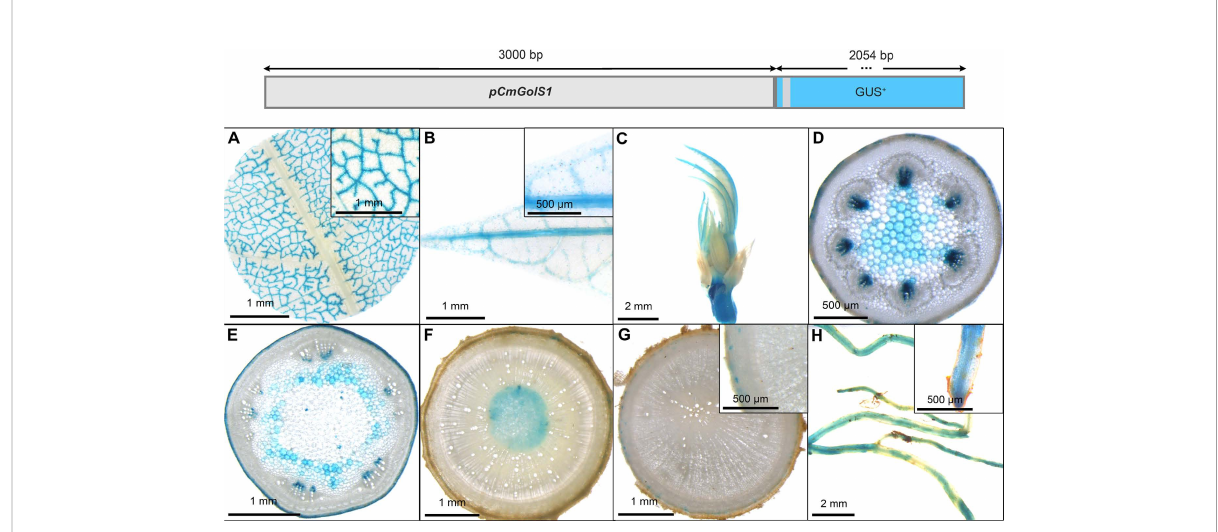
FIGURE 5 Representative GUS staining pattern of four pCmGolS1 promoter-reporter lines. (A) Source leaf (Inlay = Close-up), (B) Sink leaf (Inlay = Close-up), (C) Emerging leaves, (D) Petiole cross-section, (E) Upper stem cross-section, (F) Lower stem cross-section, (G) Storage root cross-section (Inlay = Close-up), (H) Fibrous roots (Inlay = Root tip).